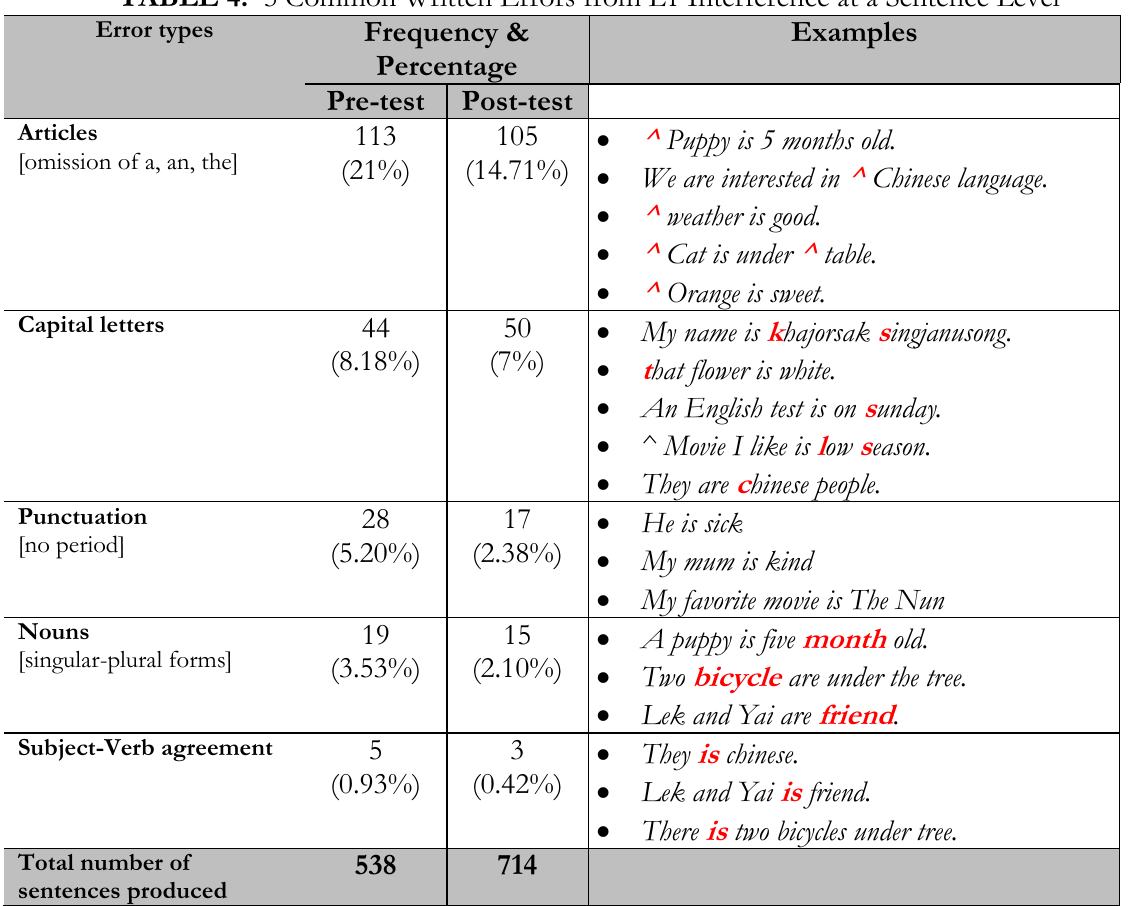
TABLE 4. 5 Common Written Errors from L1 Interference at a Sentence